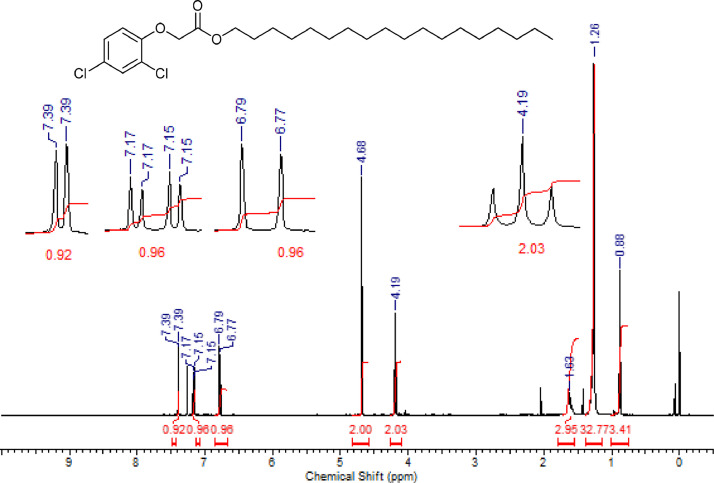
1H NMR (CDCl3, 400 MHz) spectrum of compound 6b.